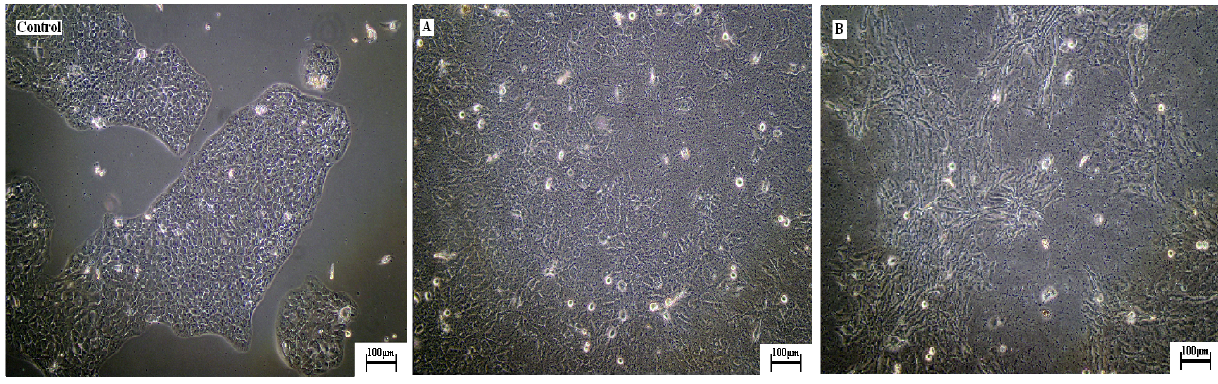
Figure 4. Light micrographs of Human skin HaCaT keratinocytes in culture upon the collagen films compared with control, (A) untreated, (B) argon